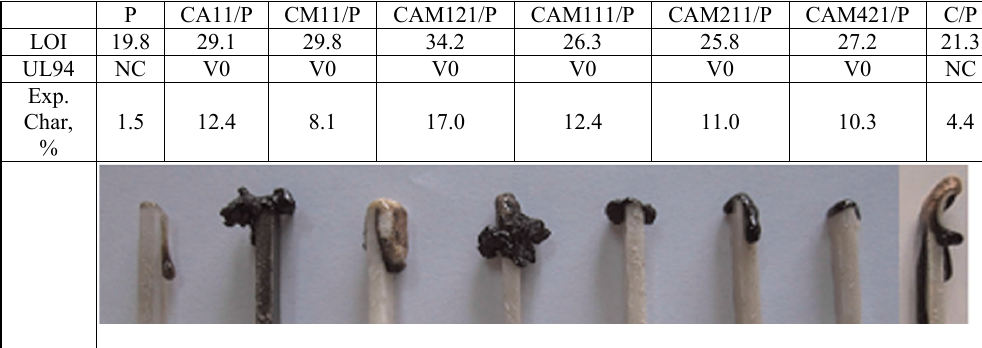
Figure 3. Photographs of specimens after limiting oxygen Index (LOI) tests of polylactic acid (PLA), 20% of fire retardant additive: CA11/P, CM11/P, CAM121/P, CAM111/P, CAM211/P, CAM421 /P, and CD/P.) and their LOI value and Underwriters’ Laboratories (UL) 94 rating. Symbol code: P: poly(lactic acid); C: cyclodextrin; A: ammonium Polyphosphate; M: Melamine. Number code: molar ration in the FR additive of C, A, M. Adapted with permission from ref.